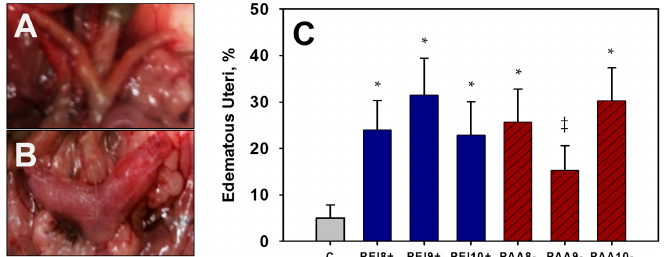
Figure 3. Representative picture of an observed typical uterus ( A ) or edematous uterus (EU) ( B ), as well as incidence of EU ( C ) observed for all treatment groups exposed to 100 mg/kg PEI-NPs or PAA-NPs in utero , and the control, C. * Significant difference between treatment group and the control ( p < 0.05). ‡ Trend between treatment and control at ( p < 0.1).